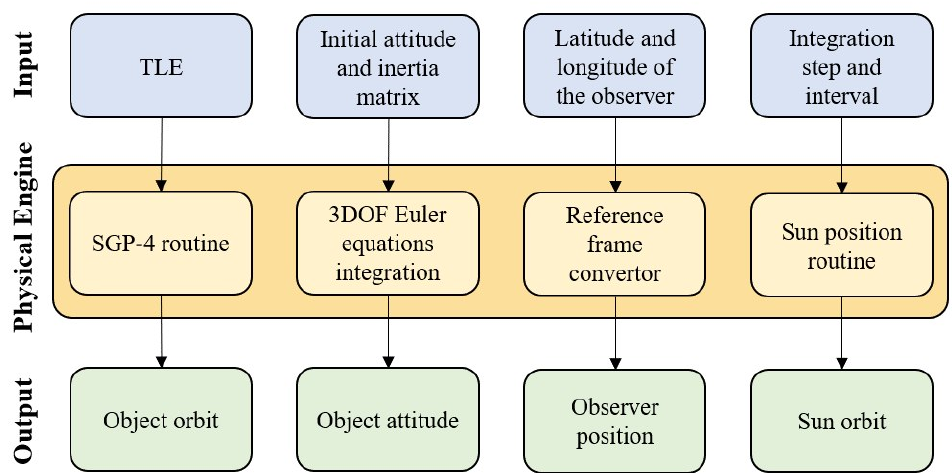
Figure 16. Physical Engine—this engine takes care of computing for each time step the position of the orbital object and its dynamical state, taking as input the TLE, the initial state with the inertial matrix. At the same time, the position of the observer and of the sun will be computed in the same integrated interval with the same sampling rate. Moreover, all the results will be given in the same reference frame.